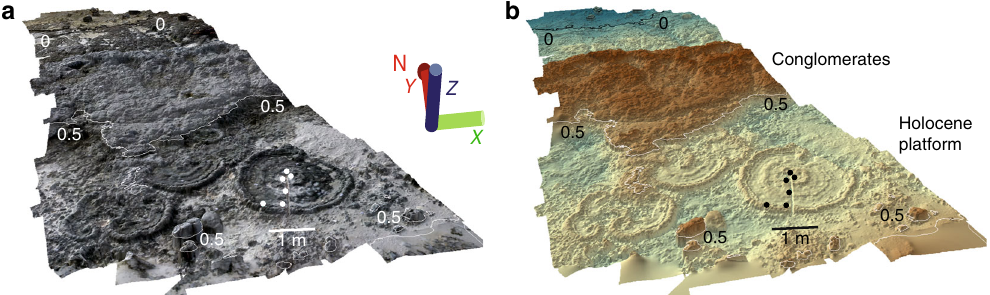
Fig. 2 Photogrammetry for a study site in Maupiti. 3D reconstruction with a photographic texture and b coloured texture indicating heights. The numbers indicated in the fi gure correspond to elevations in metres. Microatolls are located on the Holocene platform and partly covered by conglomerates. One of these microatolls was slabbed for palaeoclimate analysis. Circles indicate position of the samples MAU-97 – 102. The scale changes due to the perspective view. Agisoft Photoscan Professional version 1.2 was used to produce the 3D model